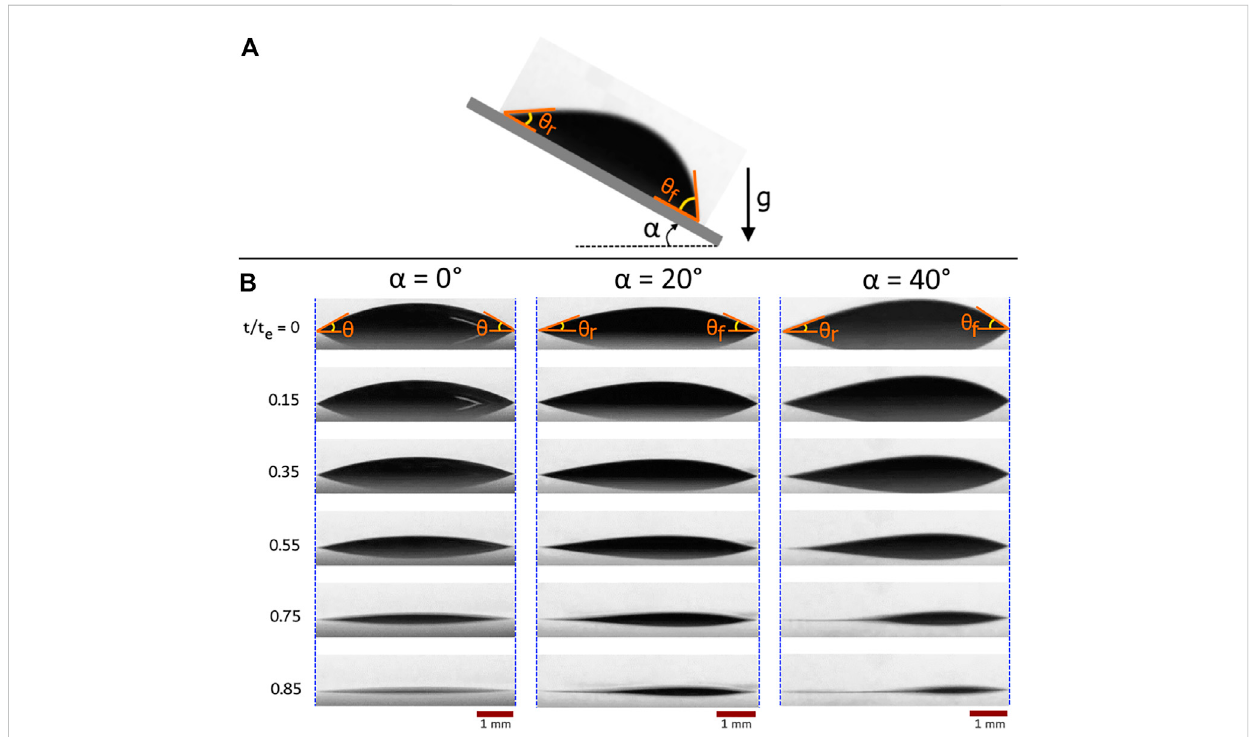
FIGURE 1 (A) A colloidal sessile drop deposited on a solid surface inclined by α . The gravity direction is denoted by g. (B) Snapshots of colloidal drops evaporating at 0 ° , 20 ° , and 40 ° inclination with corresponding mean contact angle, θ , rear contact angle, θ r , and front contact angle, θ f . t / t e is the normalised evaporation time by total evaporation time, t e , for each drop. t e at 0 ° , 20 ° , and 40 ° inclination is 2,108, 2,924 and 3,604 s,